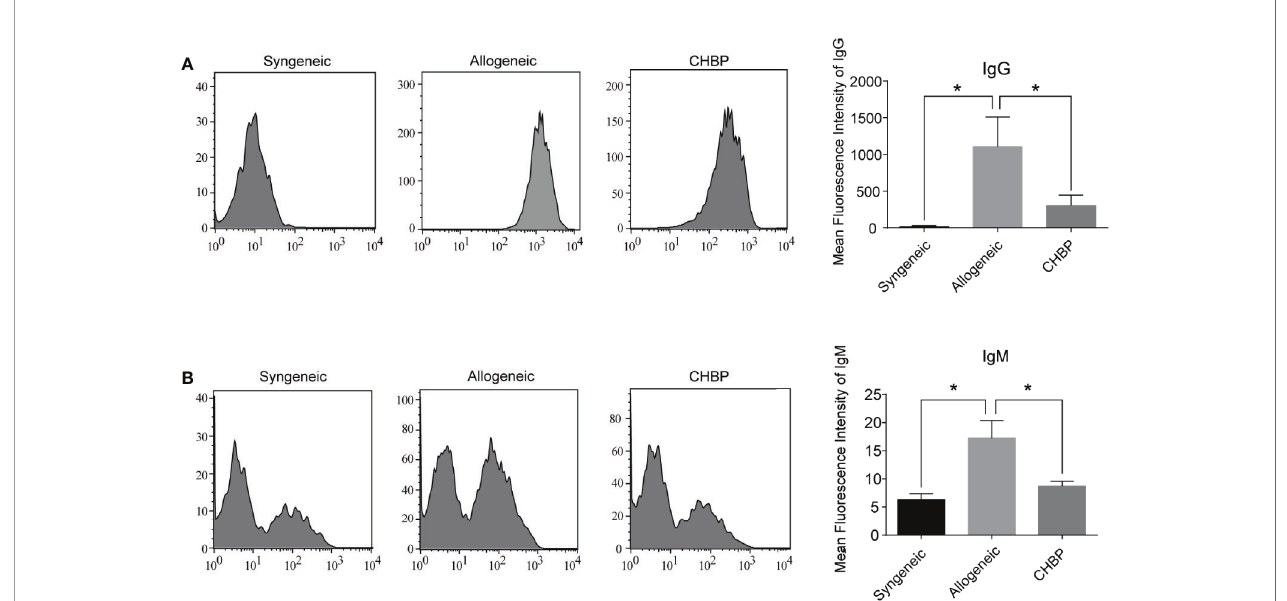
FIGURE 4 | CHBP decreased donor-speci fi c antibodies (DSAs) in recipient mice. (A) DSA-IgG and (B) DSA-IgM level in recipient serum in each group were detected by fl ow cytometry and expressed as mean fl uorescence intensity (MFI). *P <